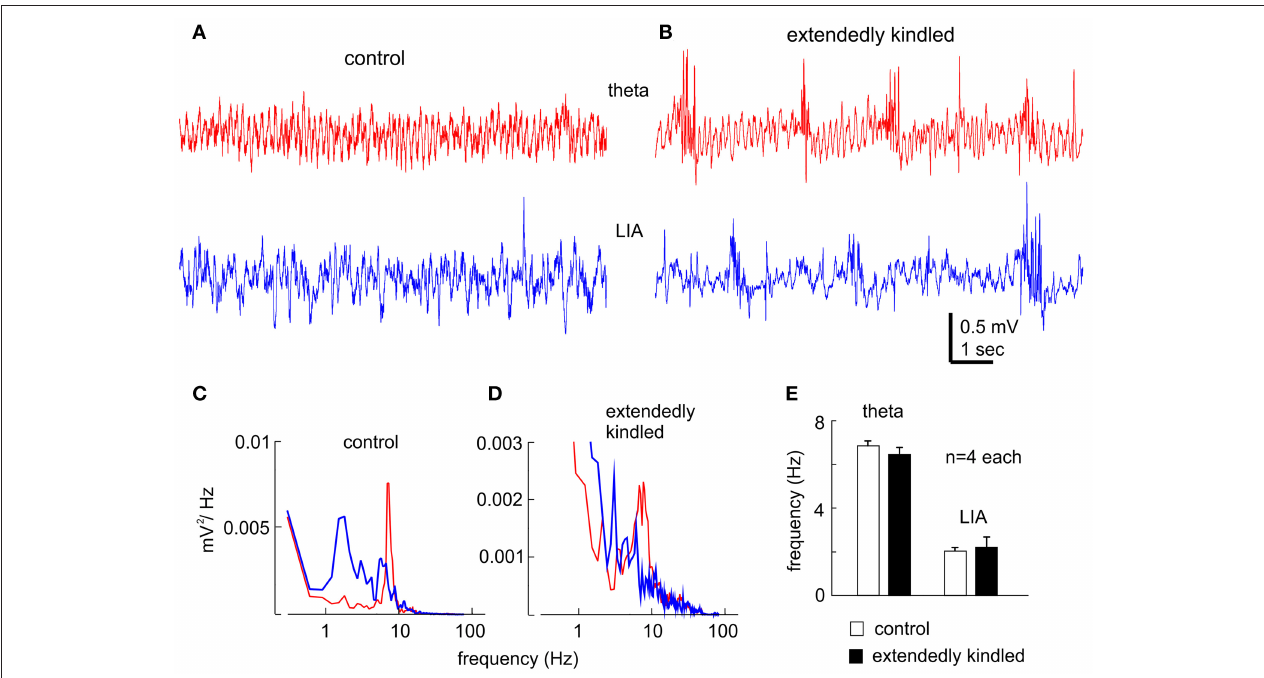
FIGURE 3 | Hippocampal EEG rhythms. (A,B) Representative traces collected from a control mouse (A) and an extendedly kindled mouse (B) showing the theta rhythm (red) and large irregular activity (LIA, blue). Note, interictal spike events in (B). (C,D) spectral plots were generated from 15-s data segments including the illustrated signals. (E) The main frequencies of the theta rhythm and large irregular activity measured from 4 control mice and 4 extendedly kindled mice. There was no significant group difference in these measures ( p ≥ 0.3, Student t